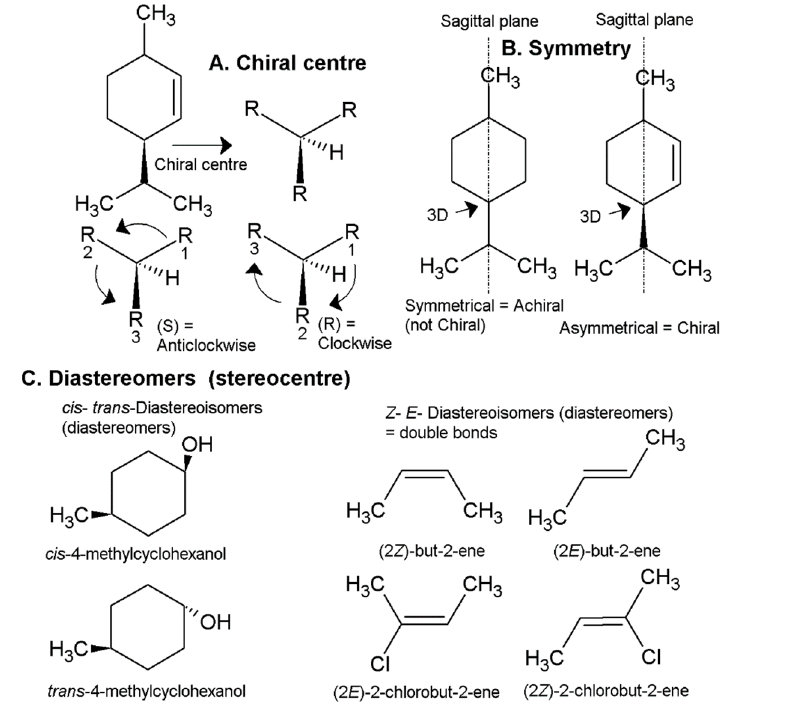
Figure 3. The stereochemistry of a molecule where the rotation of priority bonds around a chiral centre are defined as either S or R ( A ), where symmetry can influence whether something is chiral or achiral ( B ) and where two chiral centres (or stereocenter for double bonds) can result in either cis- or trans- isomerism ( C ), which can be more accurately denoted with Z- and E- if isomerism is over a double